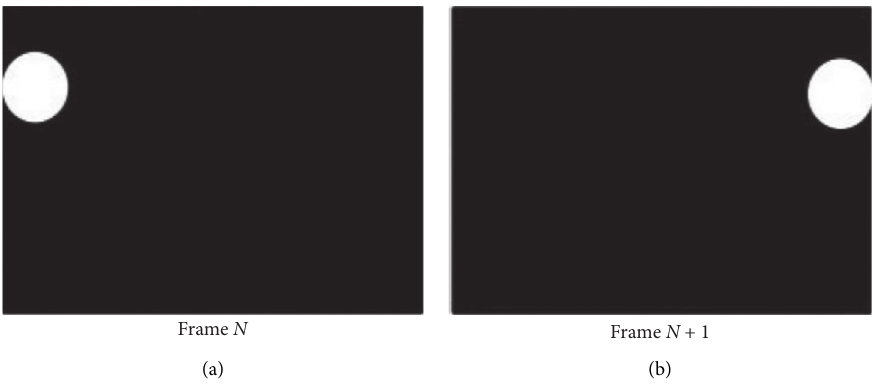
Figure 12: The relative position of the LED in two consecutive